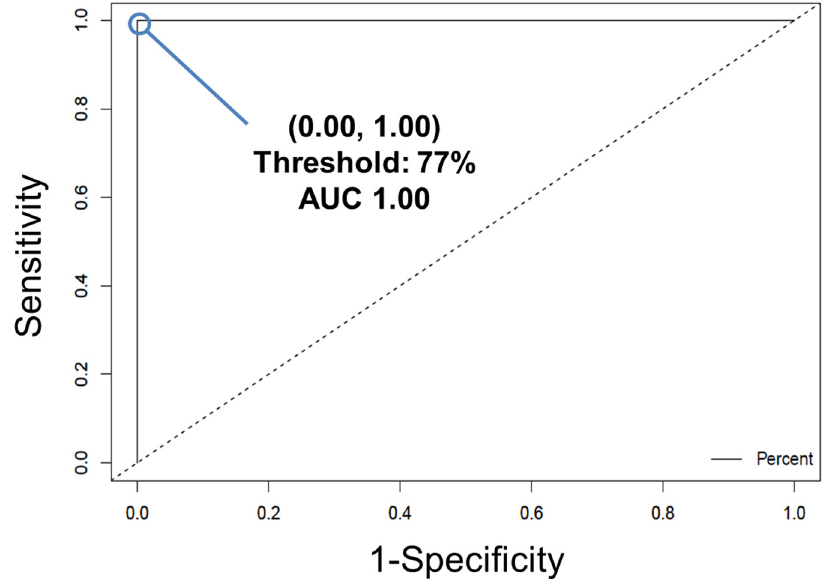
Figure 6. The ROC curve for the cross-validated PLS-DA model, trained to differentiate between diseased and healthy control mice blood serum. The true positive rate (sensitivity) of each potential discrimination threshold is plotted according to each corresponding false positive rate (1–specificity). The optimal threshold is designated by the point at (0.00, 1.00), corresponding to a threshold of 77%. Reprinted with permission from N. M. Ralbovsky, P. Dey, A. Galfano, B. K. Dey, and I. K. Lednev, Diagnosis of a model of Duchenne muscular dystrophy in blood serum of mdx mice using Raman hyperspectroscopy, Scientific Reports, 10, 11734, Copyright (2020) Springer Nature.